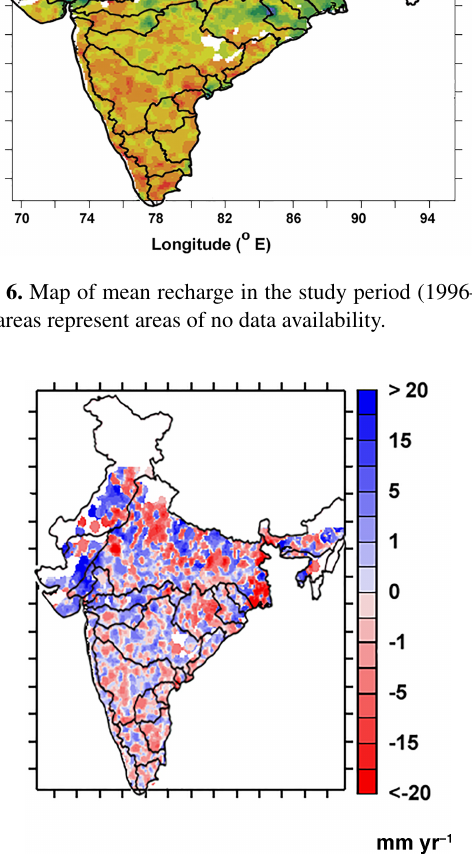
Figure 7. Maps of positive and negative trends of groundwater recharge in 1996–2015. Basin boundaries are overlaid. Blank areas represent areas of no data